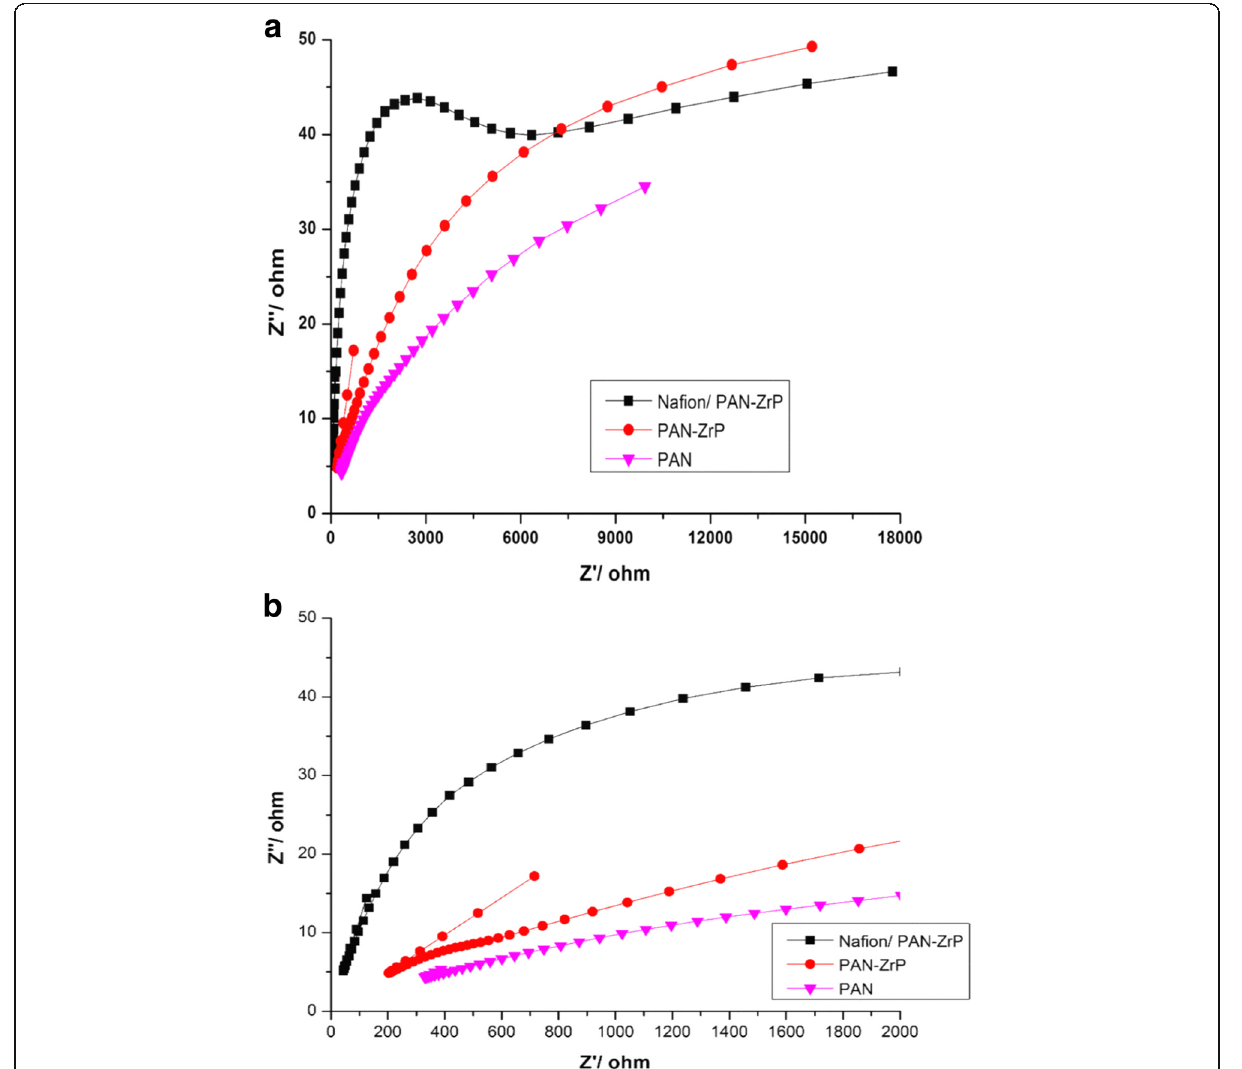
Fig. 8 Nyquist plots for PAN, PAN/ ZrP and PAN-Nafion/ ZrP nanofibers a at low frequencies and b at high